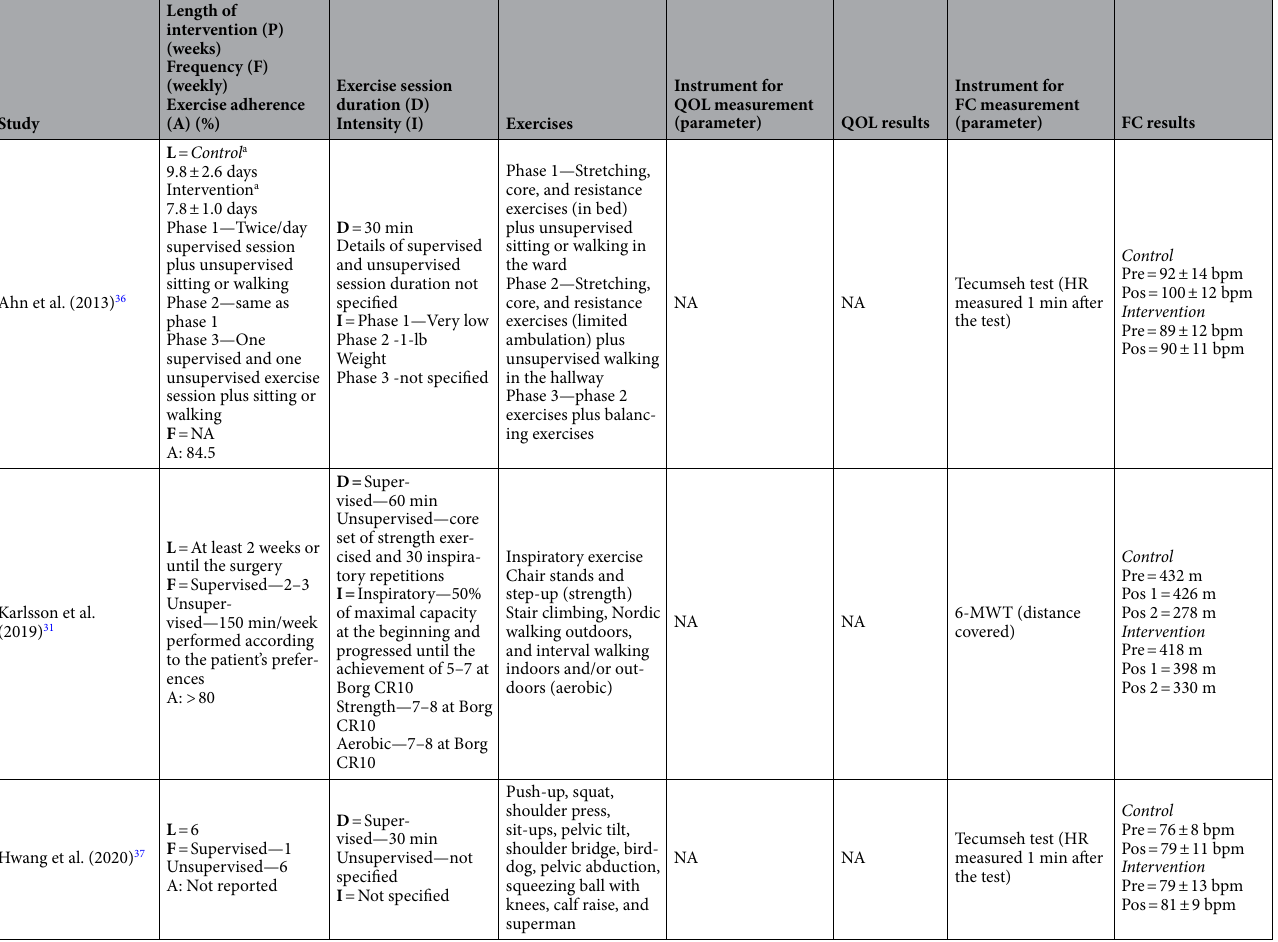
Table 5. Studies design and Quality of Life (QoL) and Functional Capacity (FC) outcomes of exercise interventions with some level of supervision (i.e. mixed) in colorectal patients. The results of Karlsson et al.